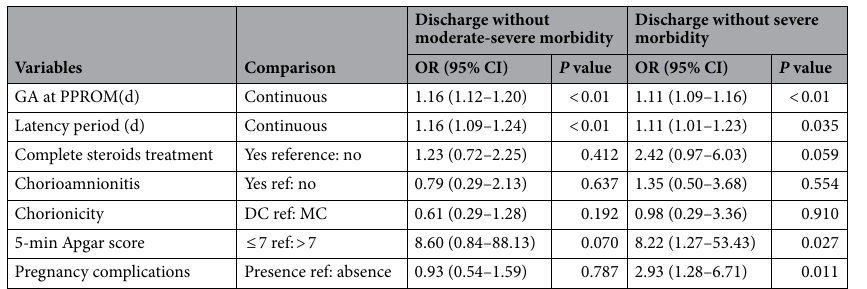
Table 5. Binary logistic regression analysis of discharge without severe and moderate-severe morbidity. OR > 1 indicates improved odds of discharge without severe and moderate-severe morbidity relative to the comparison group. OR odds ratio, GA gestational age, PPROM pretem premature rupture of membranes, DC dichorionic, MC monochorionic.